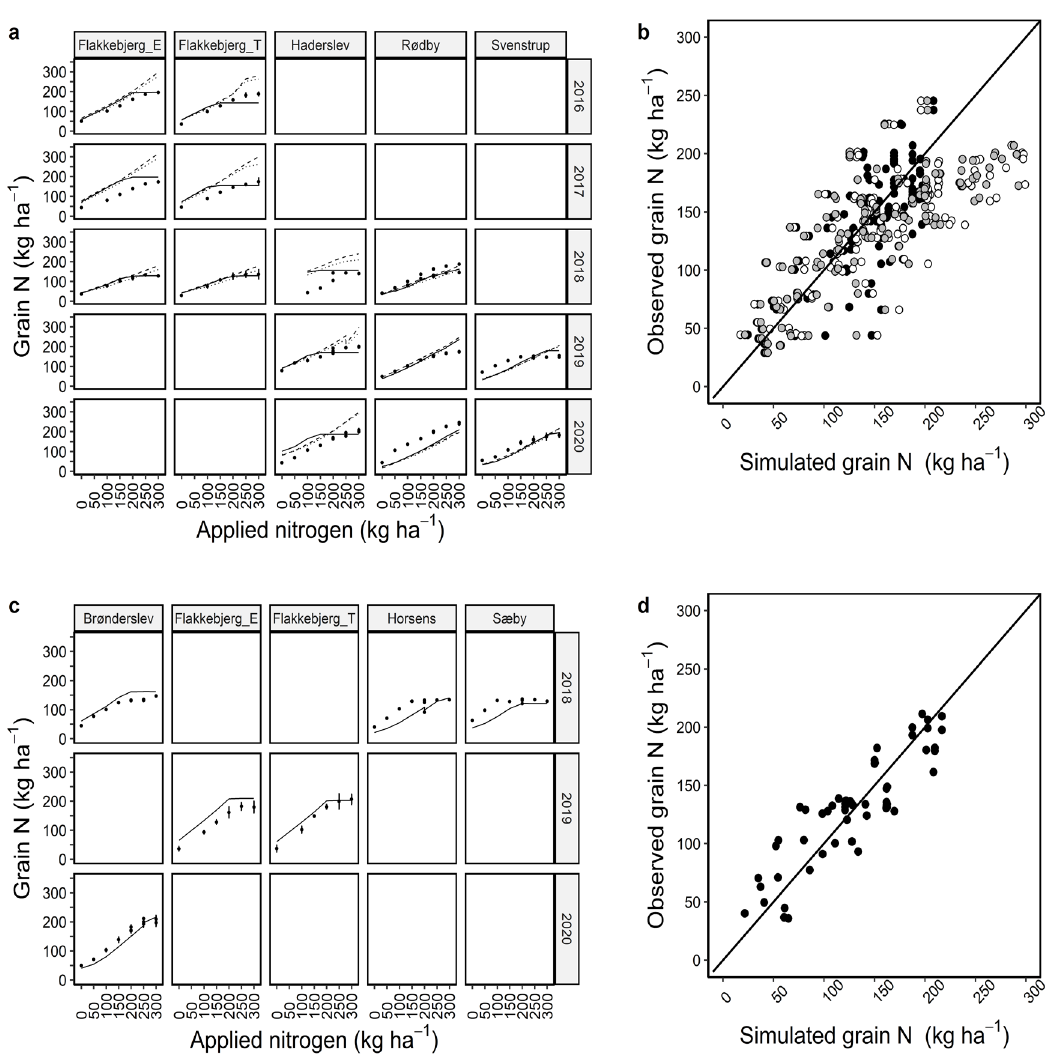
Figure 5. Calibration ( a , b ) and evaluation ( c , d ) of APSIM winter wheat grain N under 7–13 nitrogen management scenarios. Black circles are observed data points and solid, dashed, and dotted lines are model outputs with Dan_winter, default, and cultivars, respectively ( a , c ). Black, white, and grey circles represent model outputs using Dan_winter, default, and modified cultivars, respectively ( b , d ). Diagonal black lines in b and d are 1:1 lines. Discontinuous lines (e.g., Brønderslev and Sæby) at >200 kg N application indicate the simulation outputs with single dose or split applications of N at the locations in the same year (Table S1). For Rødby in 2018, discontinuous line also indicated two simulations with different sowing dates.